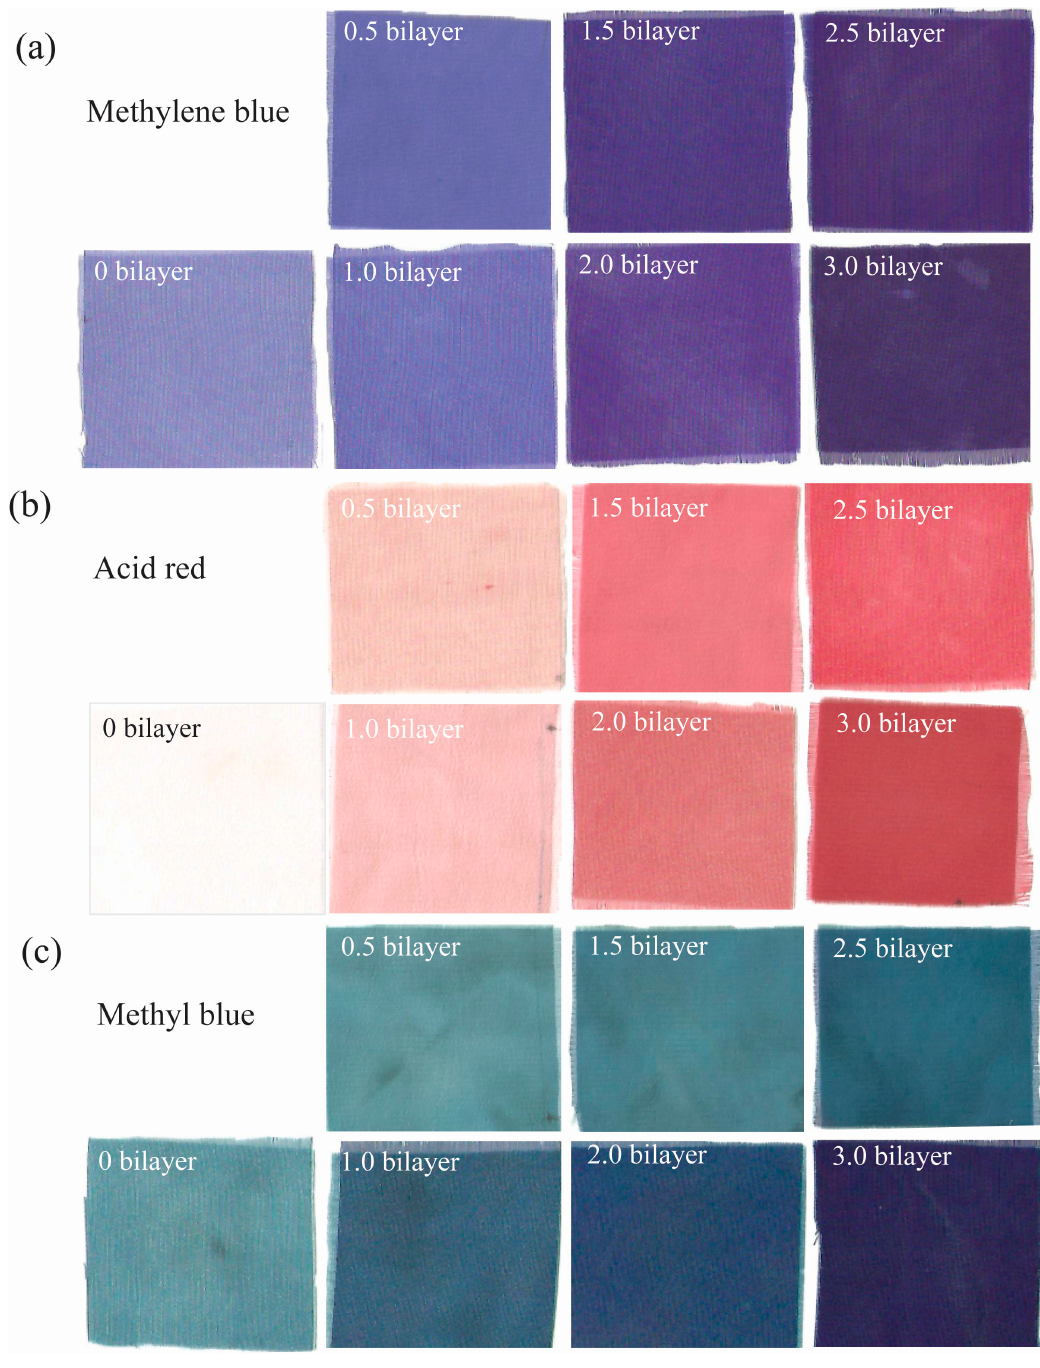
Figure 9. Photos of PET fabrics modified with different bilayer of PE membranes, ( a ) methylene blue; ( b ) acid red; and ( c ) methyl blue.